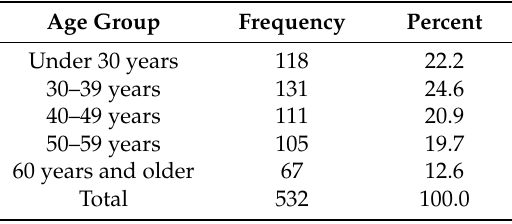
Table 2. Ages of survey respondents.